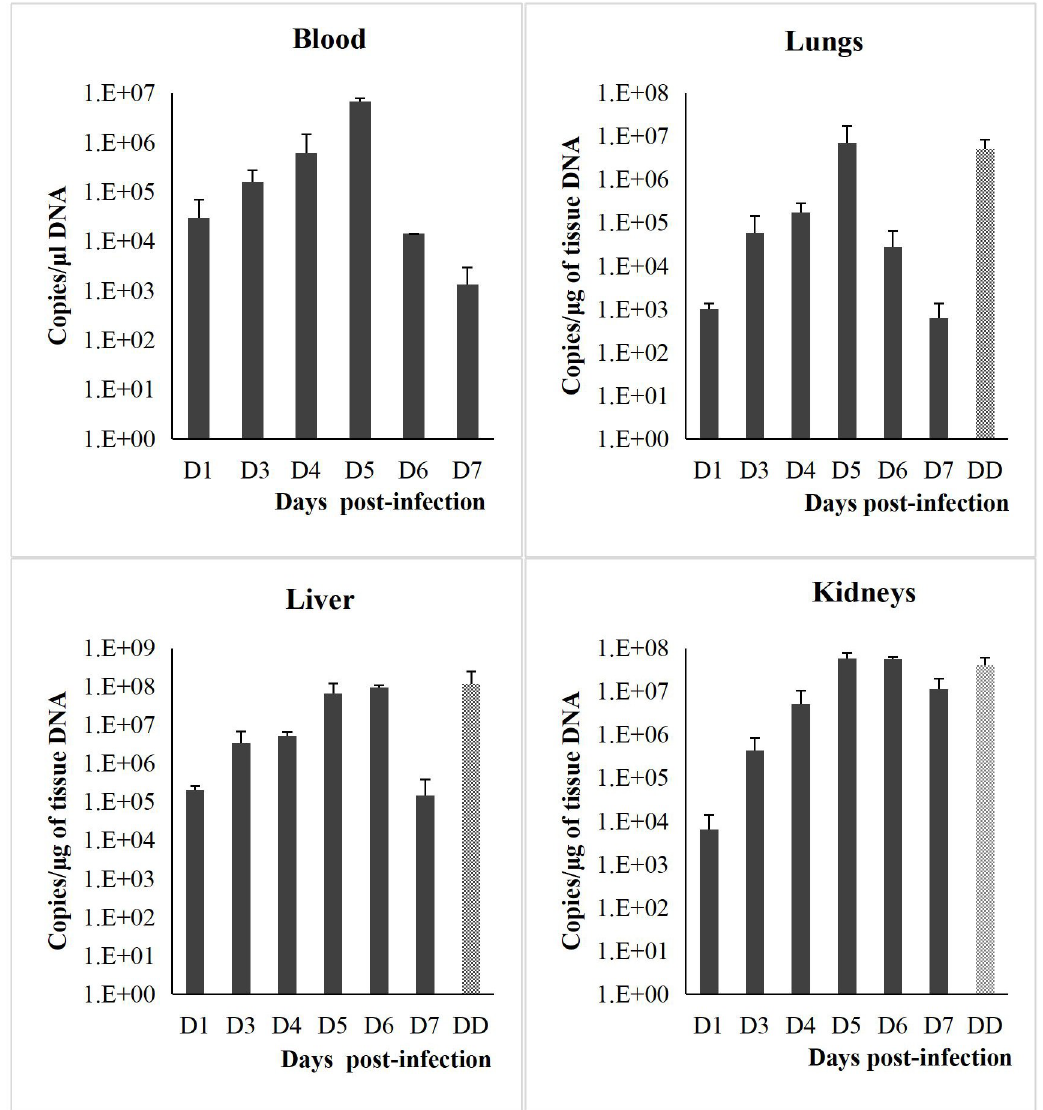
Fig 6. Leptospiral load in blood and organs tissues of hamsters infected with L . interrogans HP358. D1-D7: day 1 to day 7; DD: dead hamsters. The leptospiral copies number in blood and organs can be found in S1 Table.